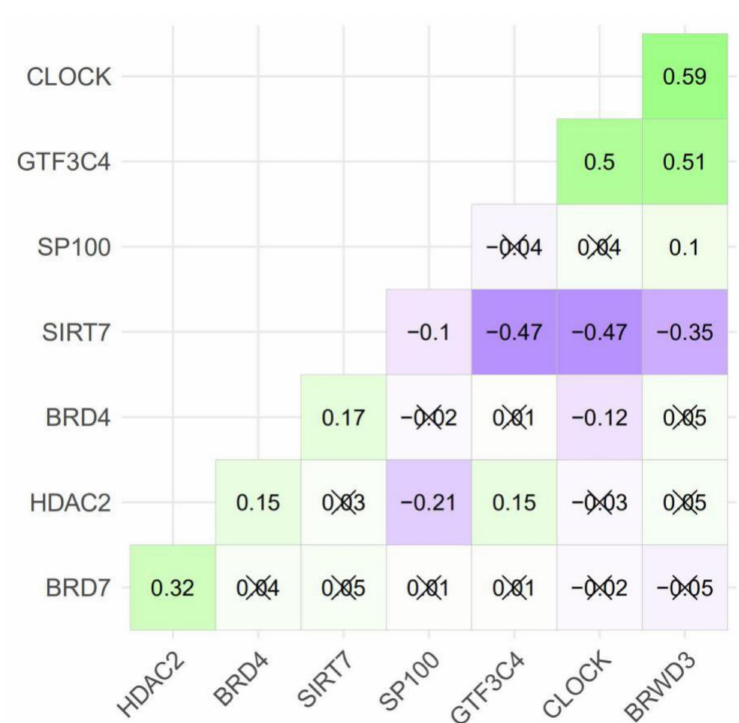
Figure 6. Gene expression correlation plot of the HAM signature genes. Numbers in each square represents the correlation e ffi ciency between the two genes of the specific row and column. Squares with a “ × ” mark are those insignificantly correlated gene pairs defined by a p -value larger than 0.05.